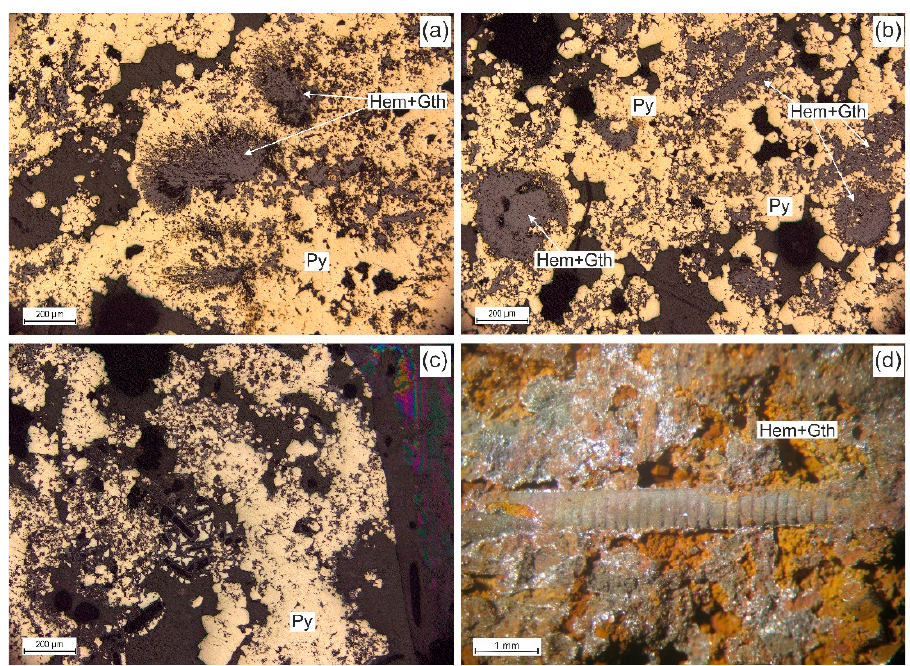
Figure 14. Major and minor minerals of a sulfide sample from st. 372. ( a ) Hematite aggregates in the central part of pyrite dendrites (sample 372 ‐ 1/1). ( b ) Concentrically layered hematite aggregates in the central part of kidney ‐ shaped pyrite grains (sample 372 ‐ 1/1). ( c ) Relic pyrrhotite overgrown by marcasite (sample 372 ‐ 1). ( d ) Mineralized tube worm in sulfides of st. 372. Fe oxides are overgrown by subhedral crystals of pyrite (up to 0.05 mm).